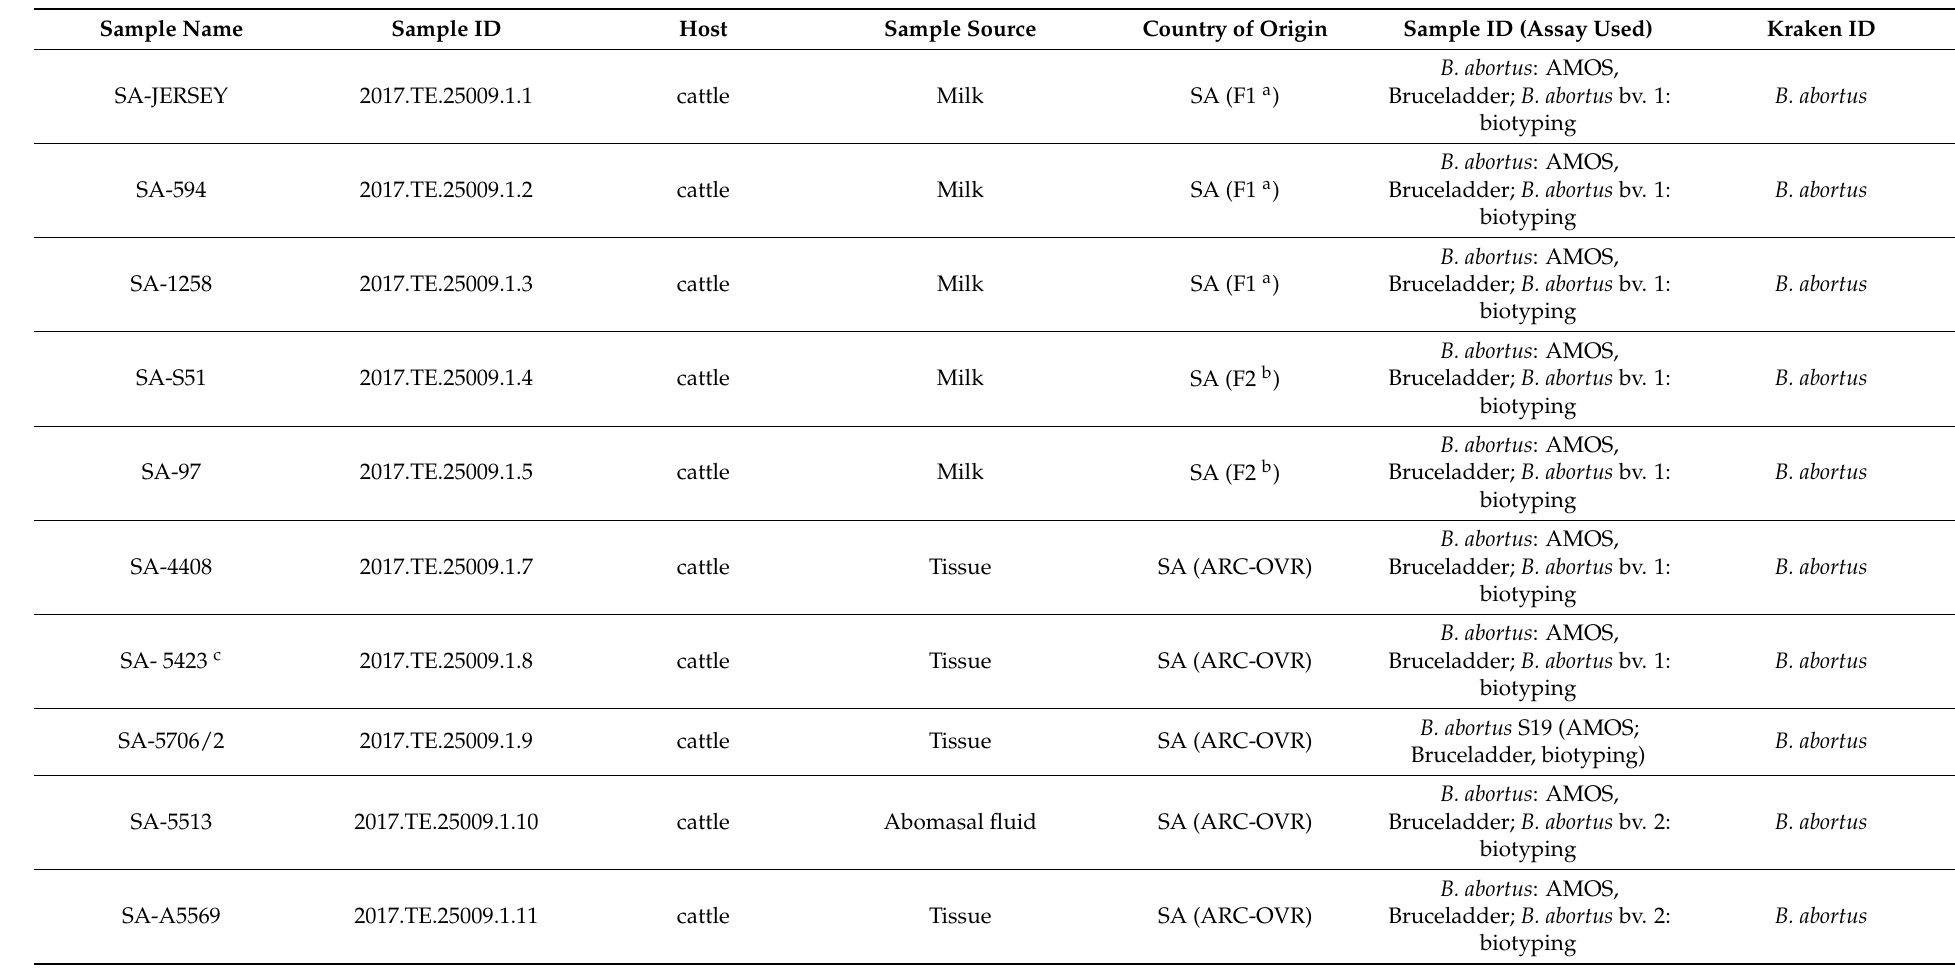
Table 2. Brucella isolates sequenced and their identity, as determined by phenotyping identification and PCR assays (AMOS and Bruce-ladder) taxonomically classified with